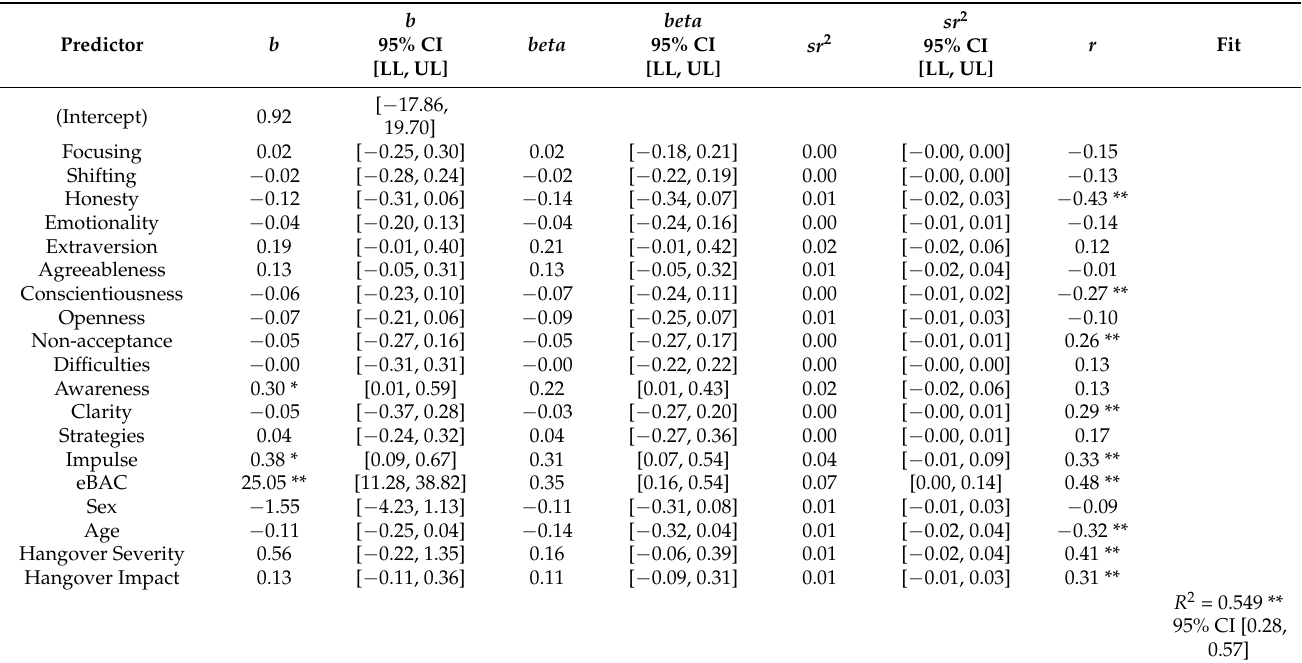
Table 3. Regression results using total AUDIT scores as the criterion.